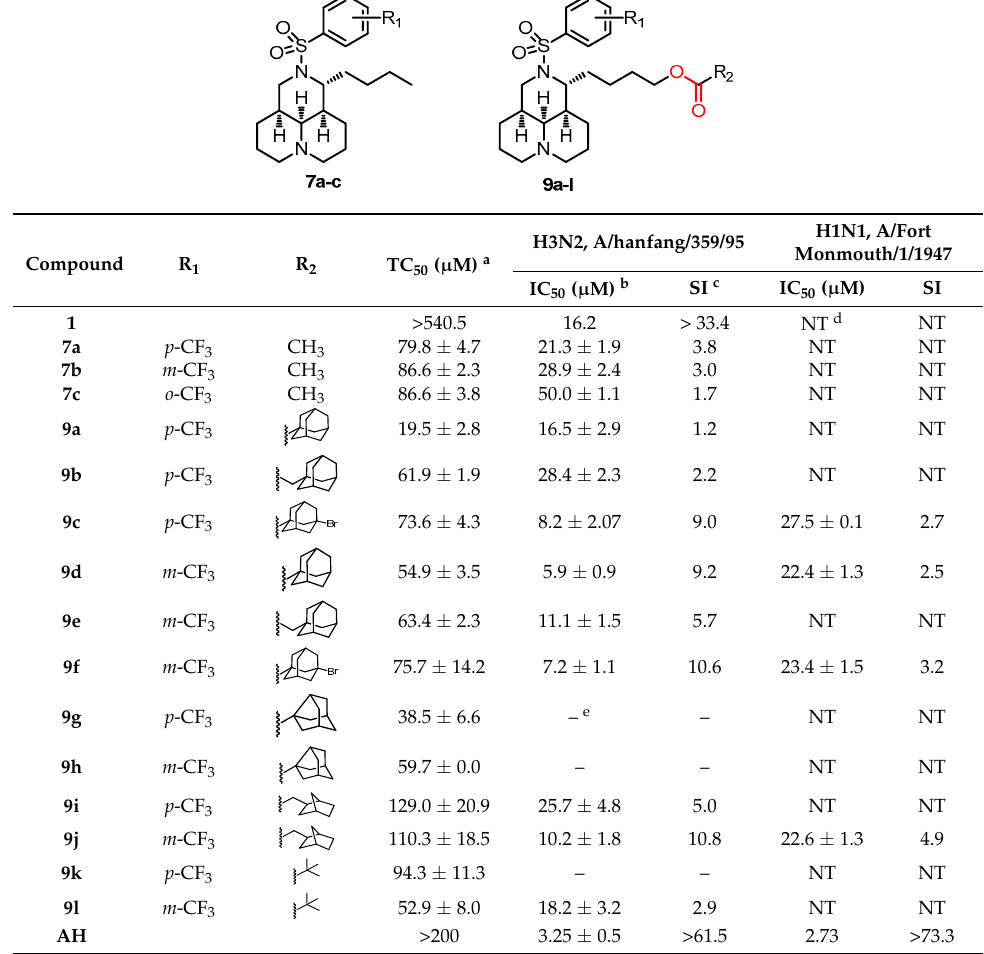
Table 1. Anti-H3N2 activities of all title compounds and anti-H1N1 activities of key compounds.